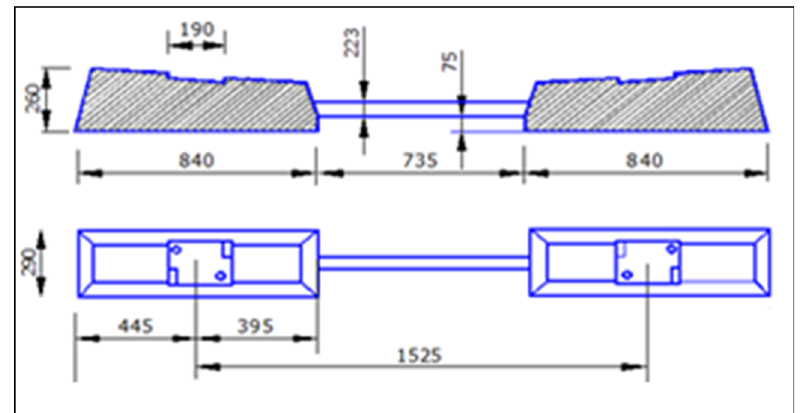
Figure 6: Twin - block sleeper U - 41.